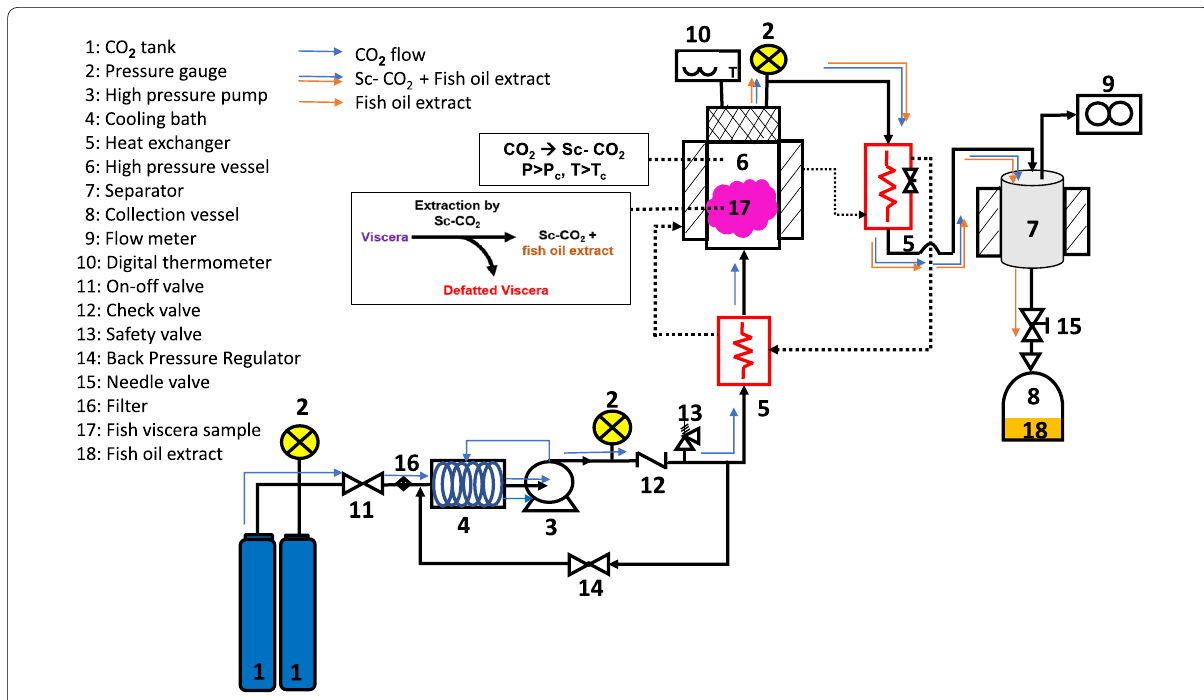
Fig. 2 Schematic diagram of the Sc-CO 2 for the simultaneous production of fish oil and enzyme